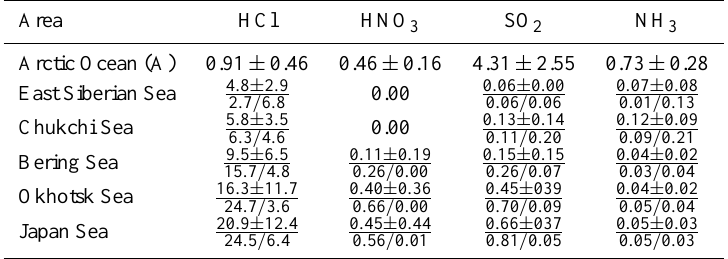
Table 8. Average concentrations of gas-phase species in the atmosphere (µgm − 3 ) on the route of RV Akademik Fedorov and Professor Khljustin (the numerator indicates the total average in the region and standard deviations; the denominator indicates the average in the forward and return directions).